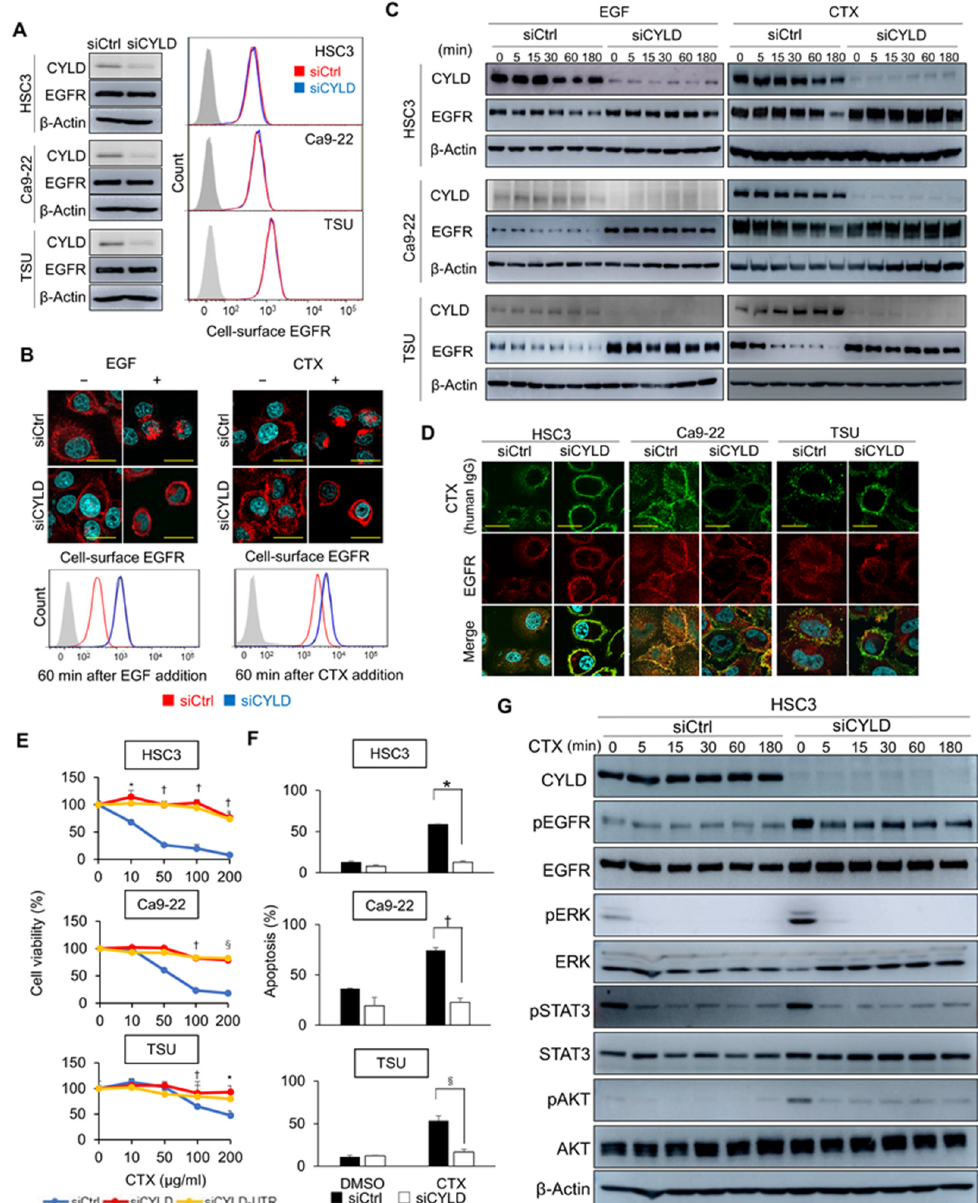
Figure 2. CYLD downregulation inhibits EGF- and CTX-induced CME of EGFR. ( A ) CYLD and EGFR expression after CYLD knockdown. HSC3, Ca9-22, and TSU cells were transfected with siRNA and then incubated for 48 h. The expression of total CYLD and EGFR was analysed by using Western blotting (left panels). Cell-surface EGFR expression was analysed by means of flow cytometry (right panels). ( B ) Internalization of EGFR after EGF or CTX treatment in CYLD-downregulated cells. HSC3 cells were treated with 100 ng/mL of EGF or 100 µg/mL of CTX for 60 min. EGFR localization was analysed via immunofluorescence staining (upper panels). Cell-surface EGFR expression was analysed via flow cytometry (lower panels). Scale bars, 10 µm. ( C ) Total EGFR expression levels after treatment with EGF or CTX in CYLD-downregulated cells. HSC3, Ca9-22, and TSU cells were transfected with siRNA and were then stimulated with 100 ng/mL of EGF or 100 µg/mL of CTX for the indicated times before harvesting. The cell lysate was immunoblotted with antibodies against the indicated proteins. ( D ) EGFR and CTX localization in CYLD-downregulated cells. HSC3, Ca9-22, and TSU cells were transfected with siRNA and were then treated with 100 µg/mL of CTX for 60 min. Immunofluorescence staining was used to analyse the localization of EGFR and CTX. Scale bars, 20 µm. ( E ) Cell viability after CTX treatment in CYLD-downregulated cells. HSC3, Ca9-22, and TSU cells were transfected with siRNA for 48 h before treatment with 100 µg/mL of CTX for